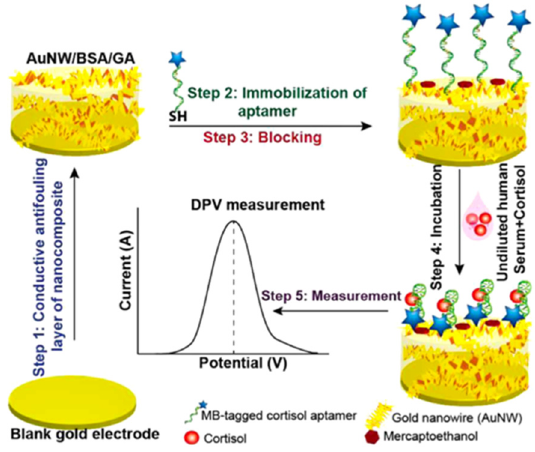
Figure 16. Fabrication of the aptasensor. (Step 1) Synthesis of a nanocomposite layer on a gold electrode (BSA/AuNW/GA). (Step 2) Immobilization of the thiolated and MB-labeled cortisol aptamer, followed by (Step 3) Blocking with mercaptoethanol. (Step 4) Incubation with the sample and (Step 5) DPV measurement (reproduced with permission from [76]. Copyright 2021 American Chemical Society).